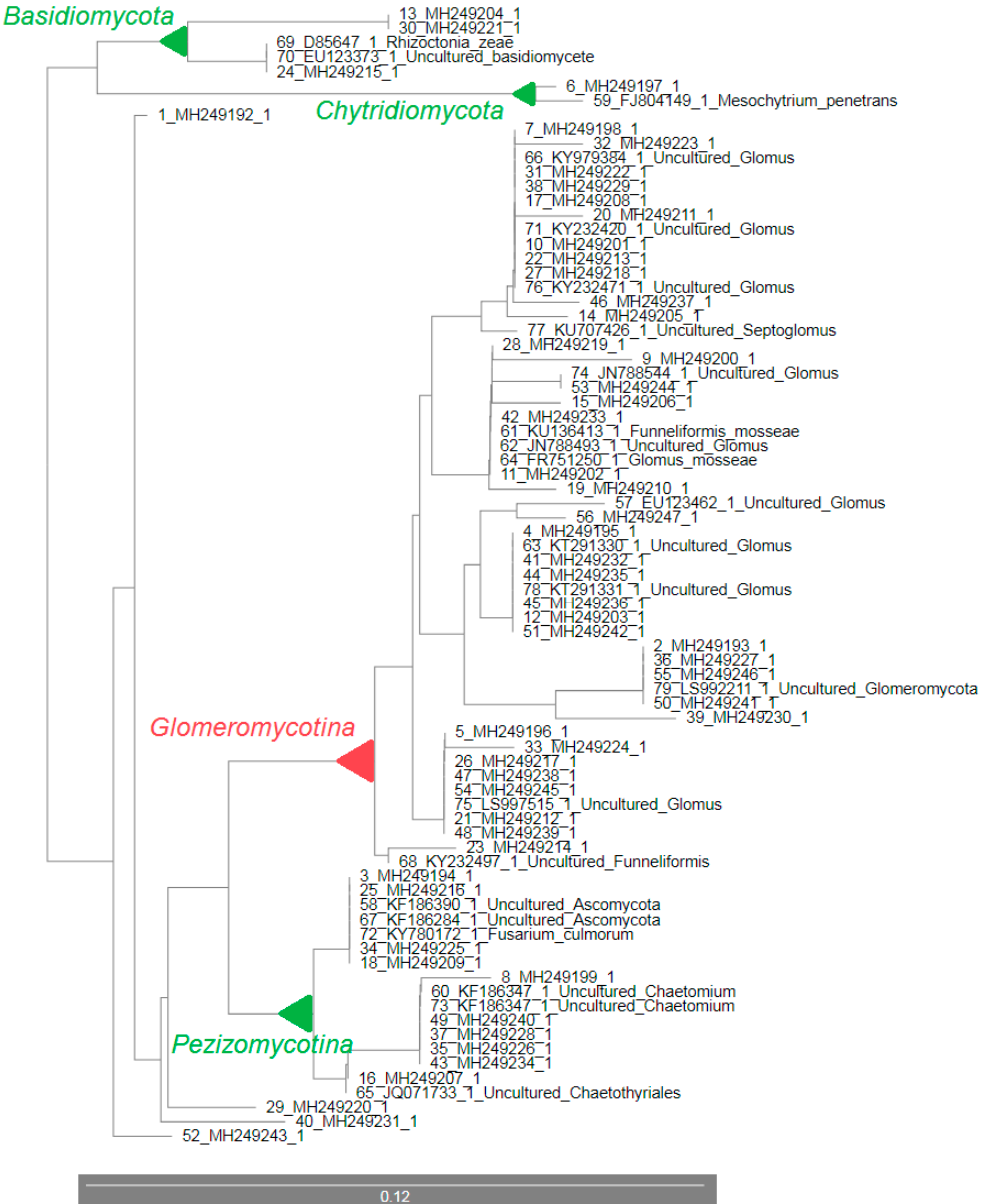
Figure 5. The phylogram constructed using Unweighted Neighbor-Joining method generated from the 18S rDNA sequences obtained from the rhizosphere of Arundo donax in the soil with 15 t/ha of sewage sludge (SS) with the sequences of fungi with the highest similarity (our sequences are indicated only with GenBank